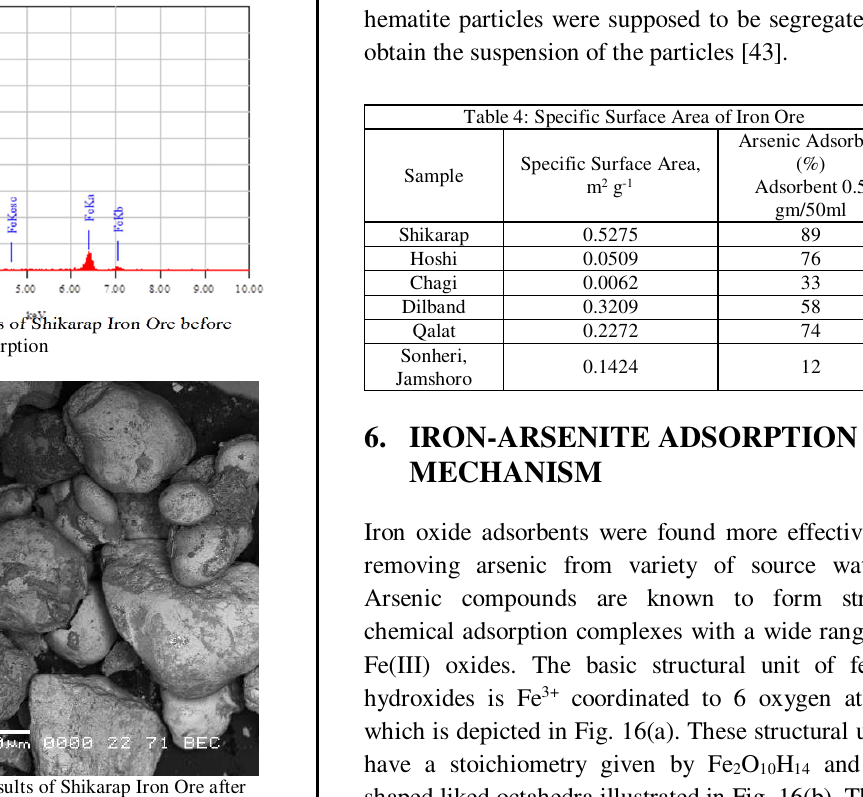
Fig. 15(a): Morphological Results of Shikarap Iron Ore after Adsorption